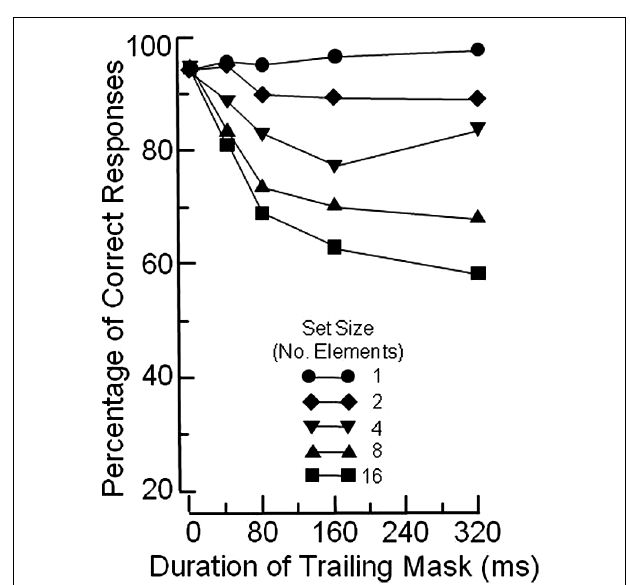
FIGURE 2 | Mean percentage of correct identifications of the orientation of the gap in the target ring, using the paradigm illustrated in Figure 1. Redrawn from Figure 4 in Di Lollo etal.